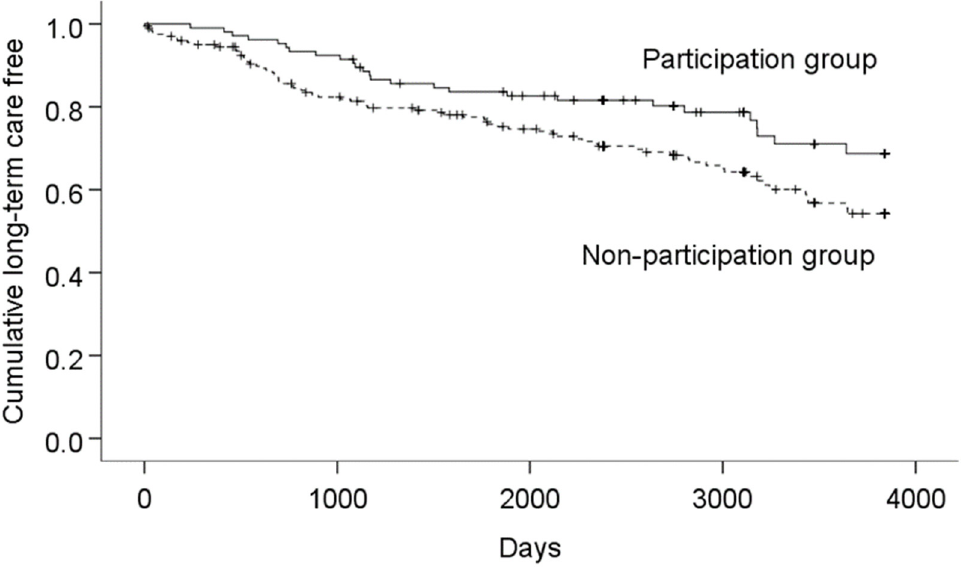
Figure 2. Comparison of days until receiving a new long-term care certification between the partic- ipation and non-participation groups.